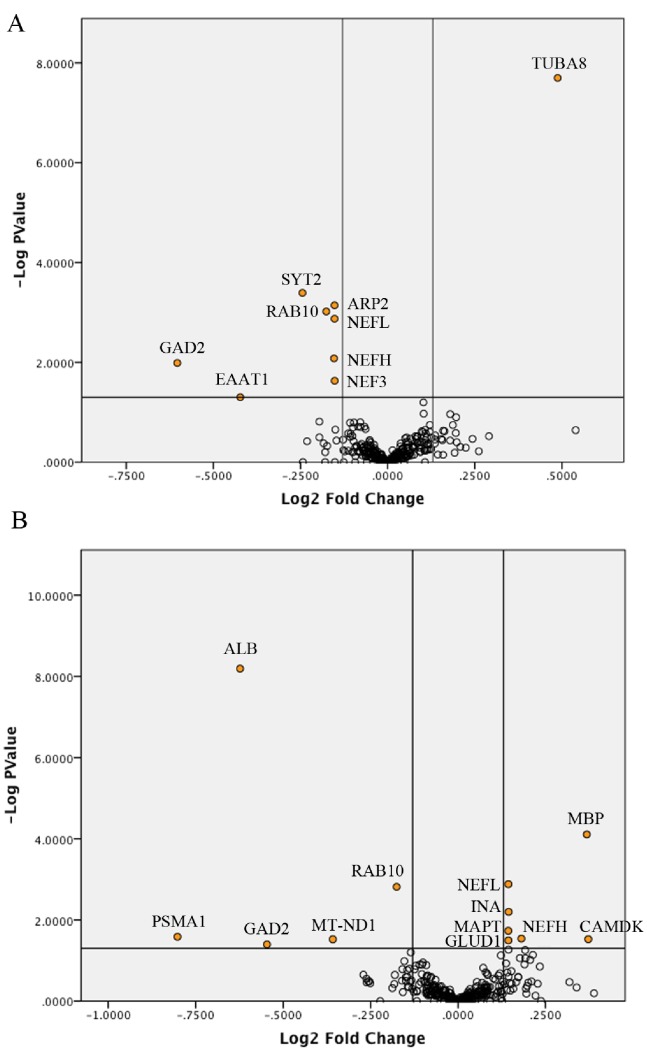
Volcano plots showing the distribution of significance and fold change of identified proteins in the (A) sham+rt-PA/sham comparison and (B) tMCAo+rt-PA/tMCAo comparison.All proteins with 2 or more peptides were plotted with fold change on the x-axis and p-value on the y-axis. Vertical lines mark a fold change of +/−10% and the horizontal line marks p  = 0.05. The 18 proteins marked in orange with text labels meet the criteria for having differential expression (>10% in either direction) and are significant (<p = 0.05).